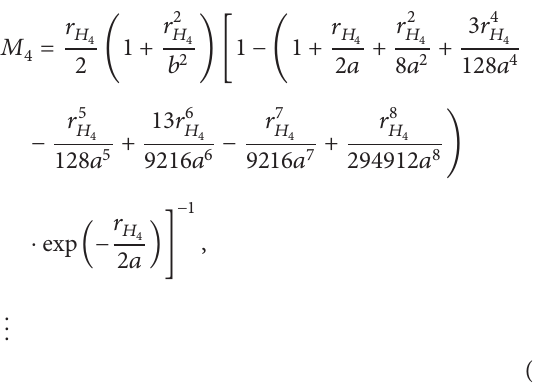
Figure 3: Plots of the relations between black hole masses and their horizon radii. The blue, red, orange, and green curves correspond to the cases of 𝑛 = 1, 2, 3, 4 , respectively, where we set 𝑏/𝑎 = 5 which has been verified to satisfy the hoop conjecture; see